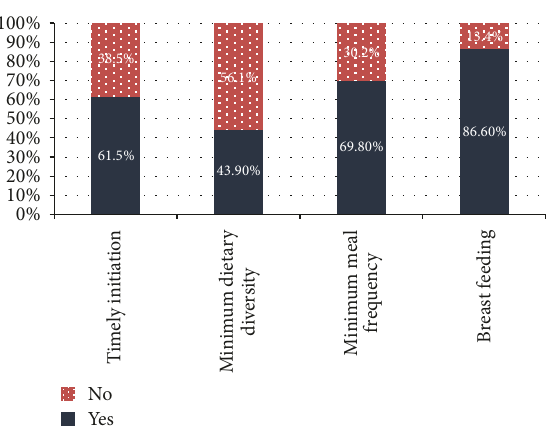
Figure 1: A bar graph on components of weaning practice in Feres Bet, Ethiopia,